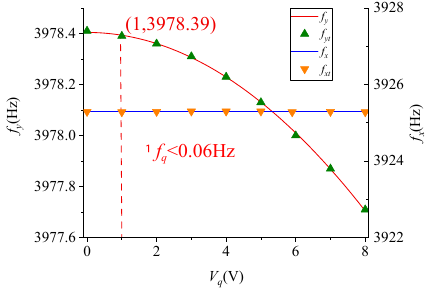
Figure 4. The effect of V q on f x and f y